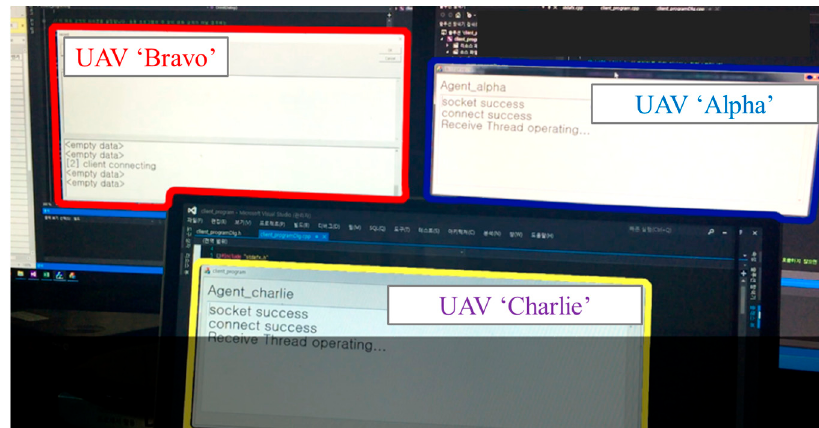
Figure A5. Experimental environments simulating user device and five UAV systems.